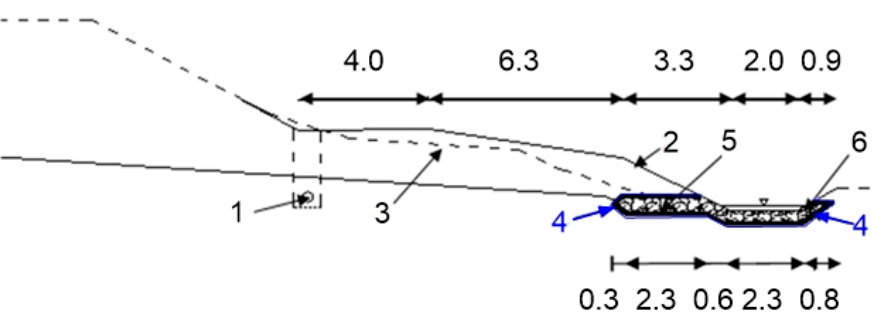
Figure 15. Bia ł obrzegi earthfill dam: drainage system construction (adapted from [48]); 1—old drainage; 2—ground level after renovation; 3—ground level before renovation; 4—nonwoven geotextile; 5—stone drainage (thickness 0.3 m); 6—crush stone (thickness 0.2 m).